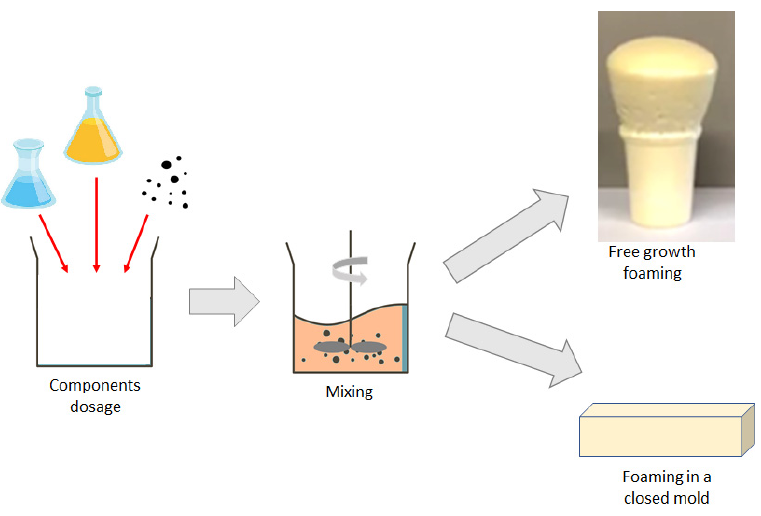
Figure 1. Scheme of composites’ preparation.